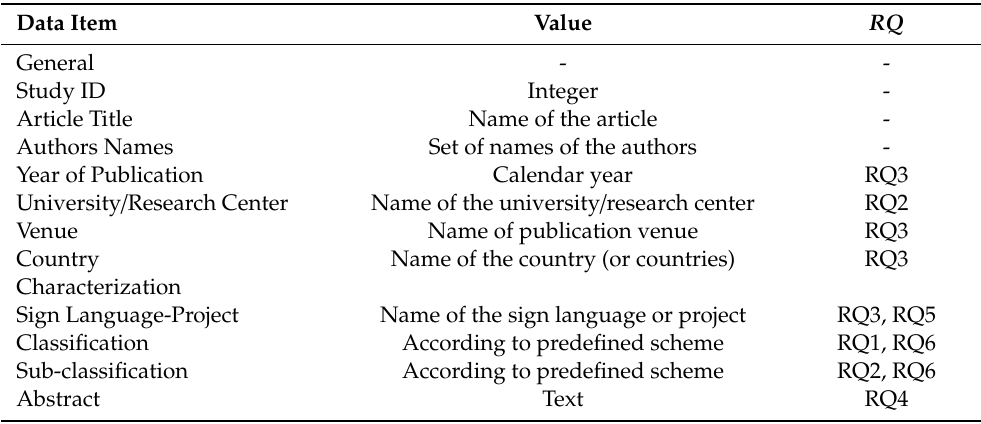
Table 1. Data extraction